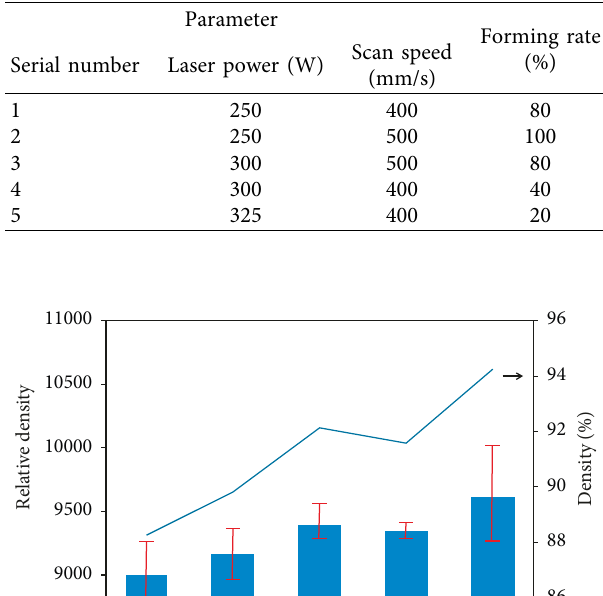
Table 3: Combination forming rate of different parameters.